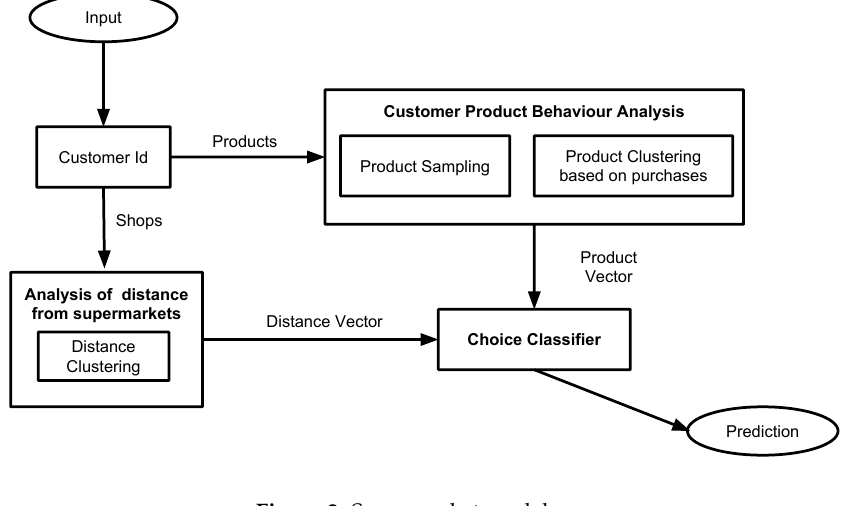
Figure 2. Supermarket